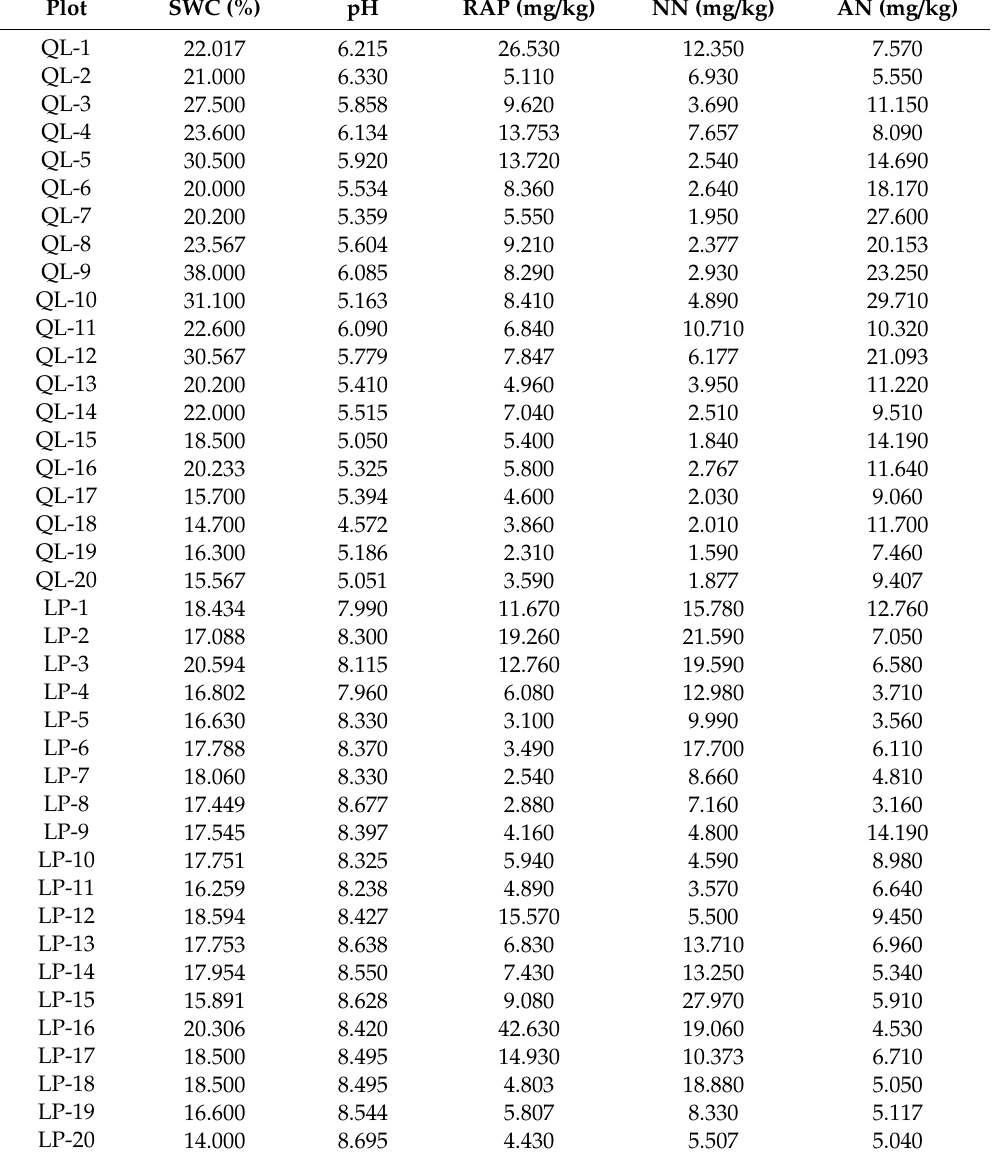
Table 1. The environmental conditions of each plot. Soil water content (SWC), rapidly available phosphorus (RAP), nitrate nitrogen (NN), ammonia nitrogen (AN). QL indicates the Qinling Mountain plots, and LP indicates the Loess Plateau